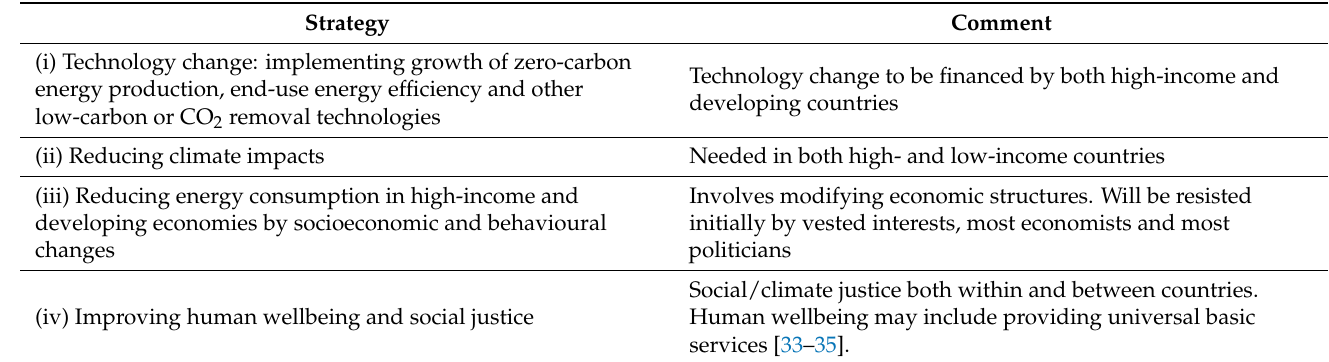
Table 3. The principal strategies to be funded in the energy descent